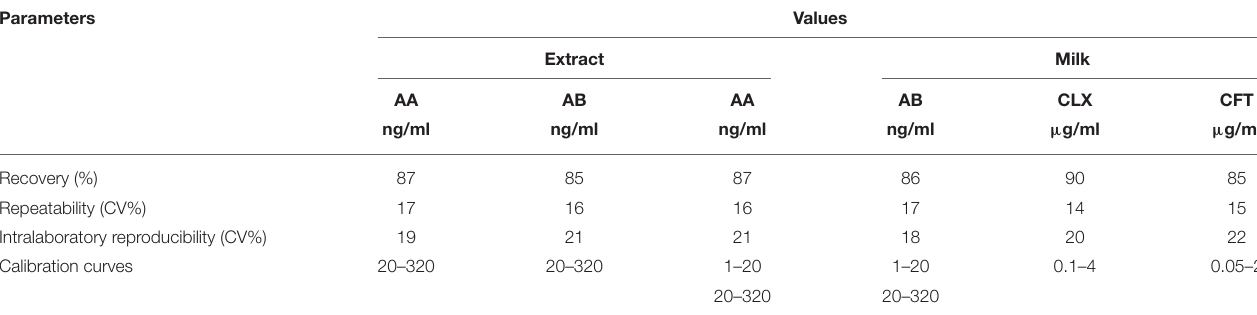
TABLE 3 | Validation parameters for aloin A and aloin B on Aloe vera extract samples and for aloin A, aloin B, cloxacillin, and ceftiofur on milk samples. Parameters